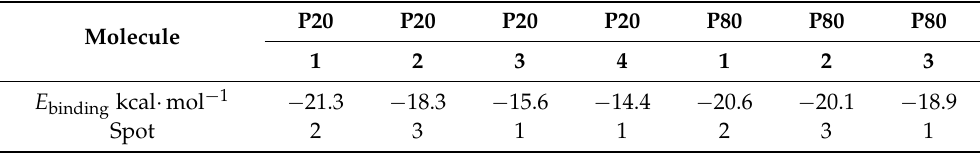
Table 4. Binding affinity and hotspot for the lowest energy solutions found for polysorbate 20 and 80 solutions.